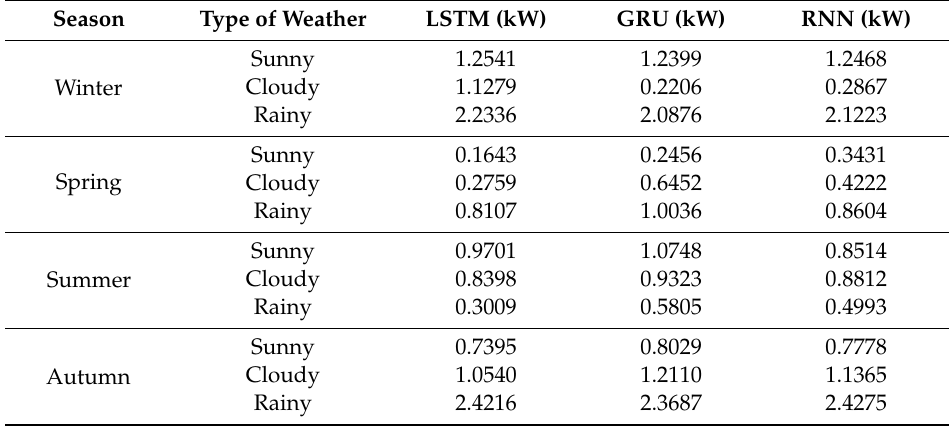
Table 8. RMSE of PV power prediction based on the type of weather (sunny, cloudy, and rainy).